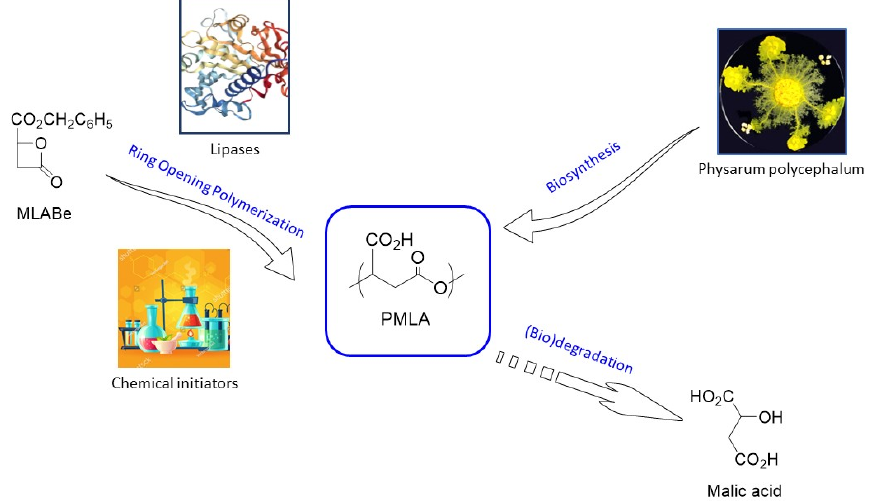
Figure 1. Structure of PMLA, methods of (bio)synthesis and degradation product.